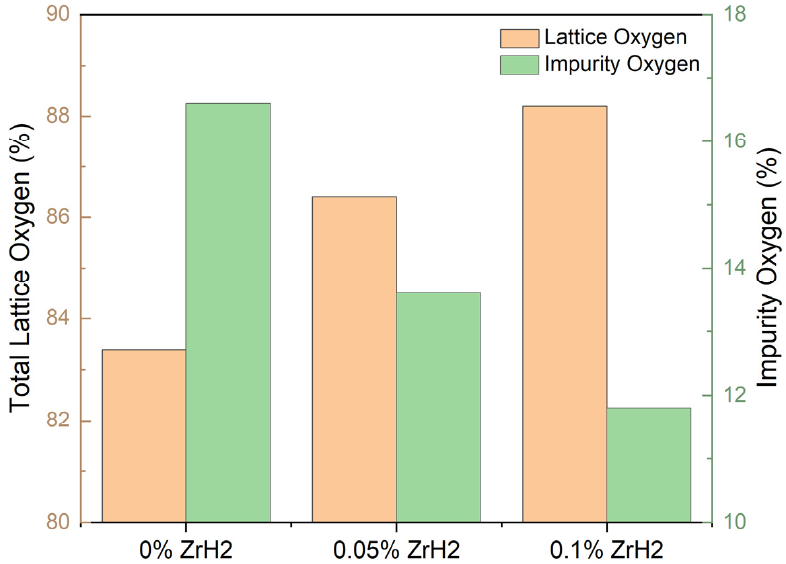
Figure 10. The content of impurity oxygen and total la tt ice oxygen.